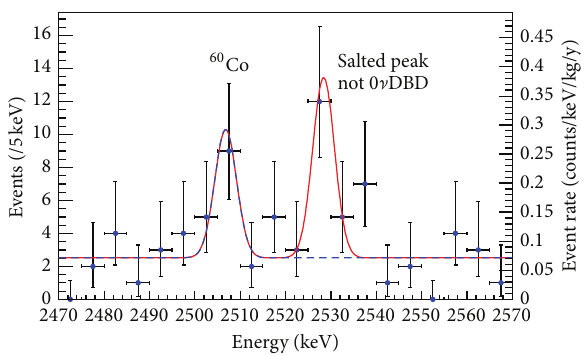
Figure 5: CUORE-0 background spectrum in the ROI, with a salted peak at the 𝑄 -value for 0 ] 𝛽𝛽 decay of 130 Te. The solid red line shows the result of an unbinned maximum-likelihood fit to the full spectrum, while the dotted blue line indicates the fit’s background component, consisting of the 60 Co peak and a uniform continuum. The fit value for the continuum background is 0.071 ± 0.011 counts/keV/kg/y (from